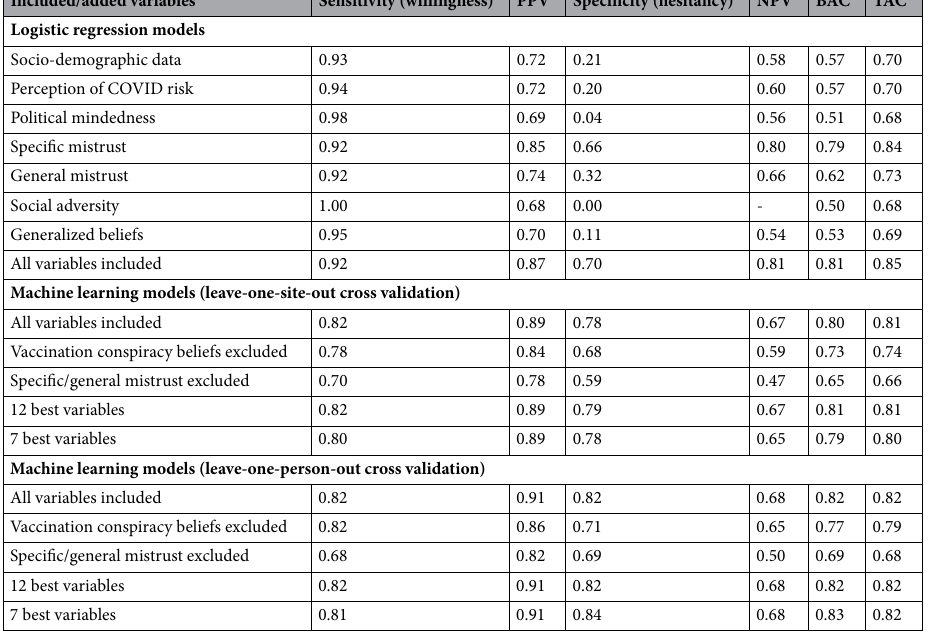
Table 4. Accuracy of the logistic regression and machine learning model (ML cross-validation using leave- one-site-out and the leave-one-person out method). PPV positive predictive value (the frequency true vaccination willing among people all predicted to be vaccination willing), NPV negative predictive value (the frequency true vaccination hesitant among all people predicted to be vaccination hesitant, BAC balanced accuracy (the average of sensitivity and specificity), TAC total unweighted accuracy.